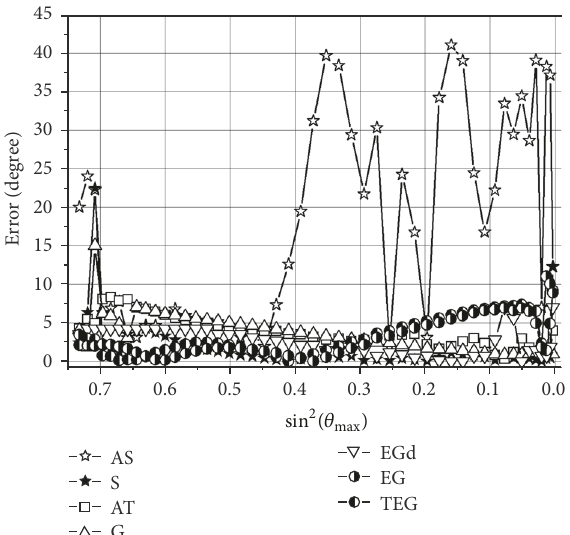
Figure 7: Techniques of low quality, variant 𝑉 𝑃3 = 3200 . The error for the fixed minimum offset.